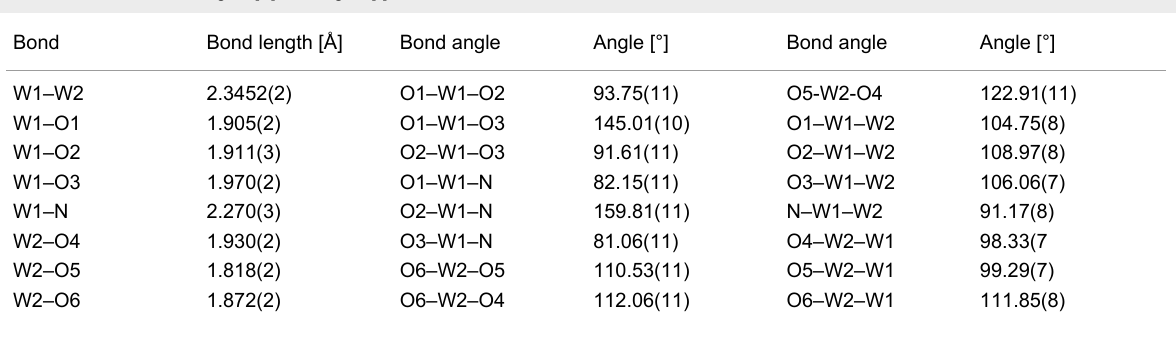
Table 1: Selected bond lengths [Å] and angles [°]: